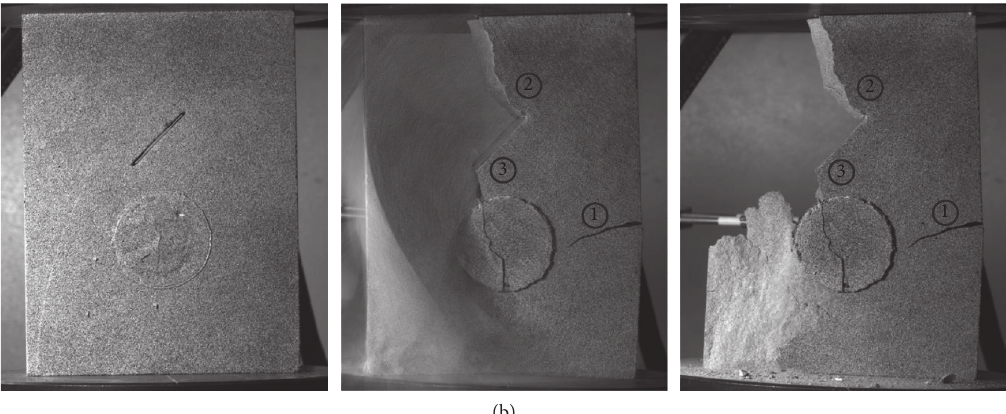
Figure 6: Crack evolution process of α � 45 ° : (a) S-45-80; (b) S-45-100.